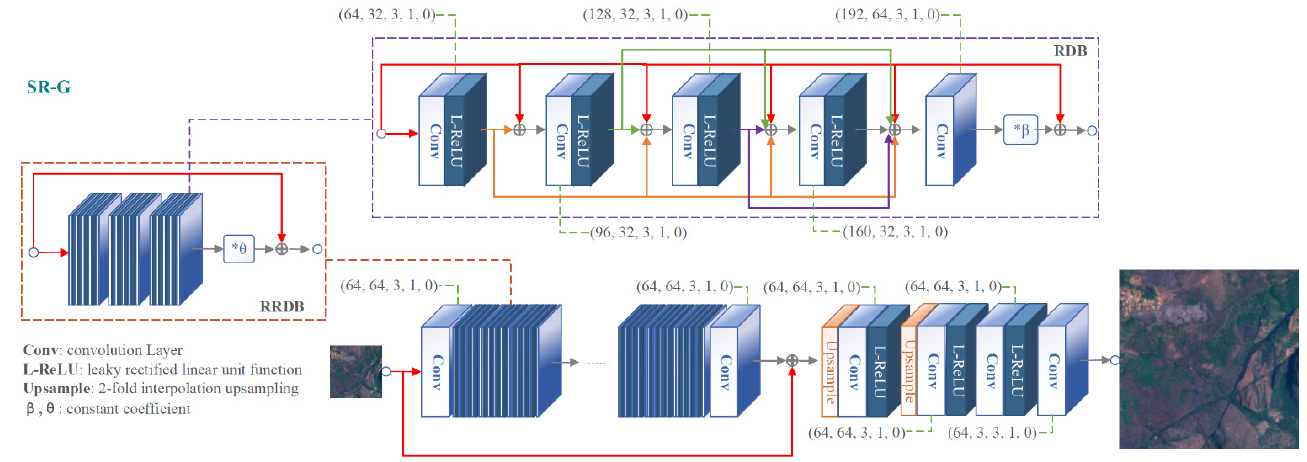
Figure 7. Structure of the super-resolution generator (SR-G).